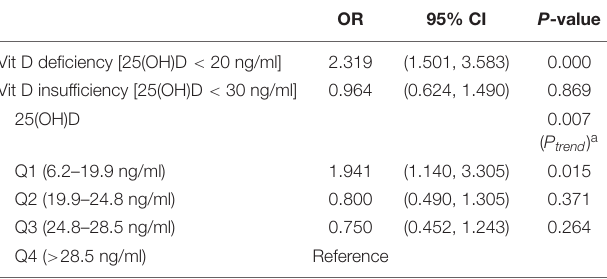
TABLE 3 | Association between vitamin D (VD) and PD risk.